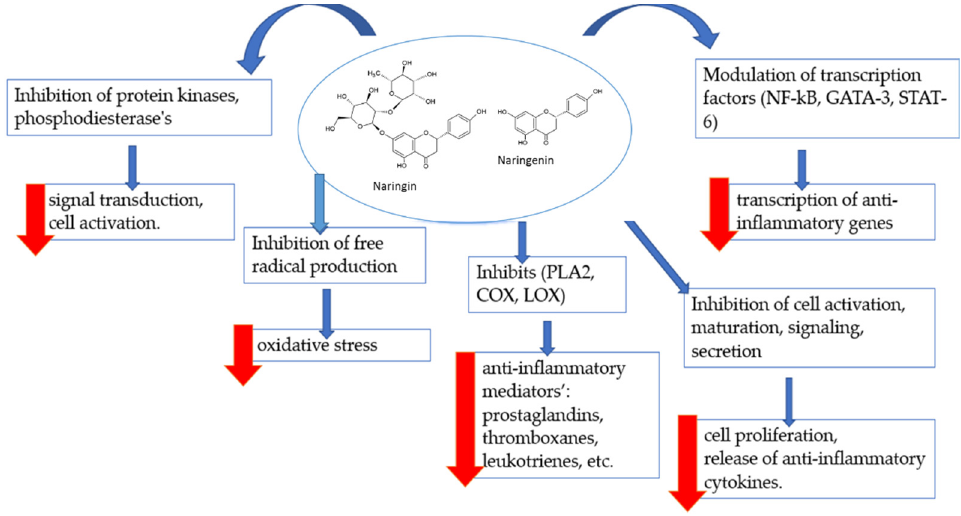
Figure 3. Anti-inflammatory mechanisms of flavonoids. COX—cyclooxygenase; DCs—dendritic cells; LOX—lipoxygenase; PLA2—phospholipase A2; STAT-6—signal transducer and activator of transcription-6.